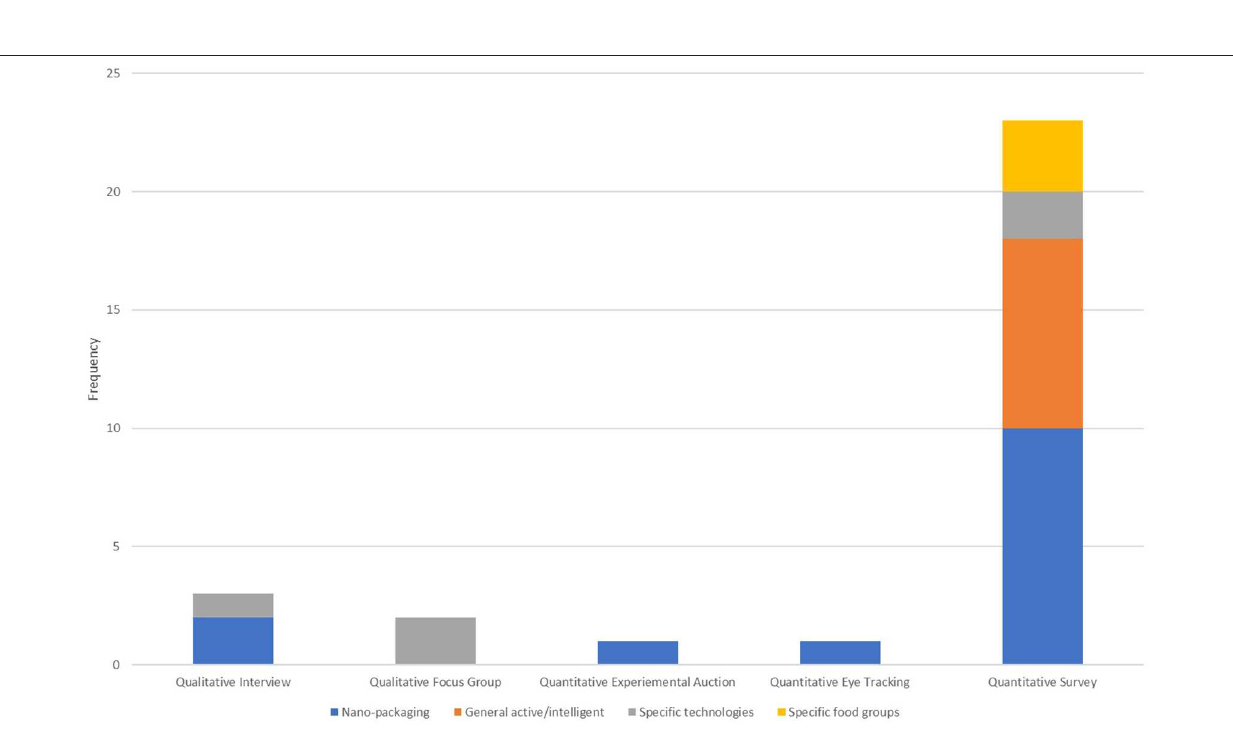
FIGURE 5 | Study methodologies